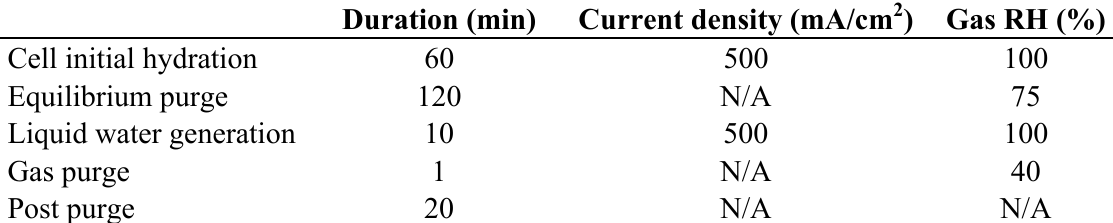
Table 1. Experimental purging with